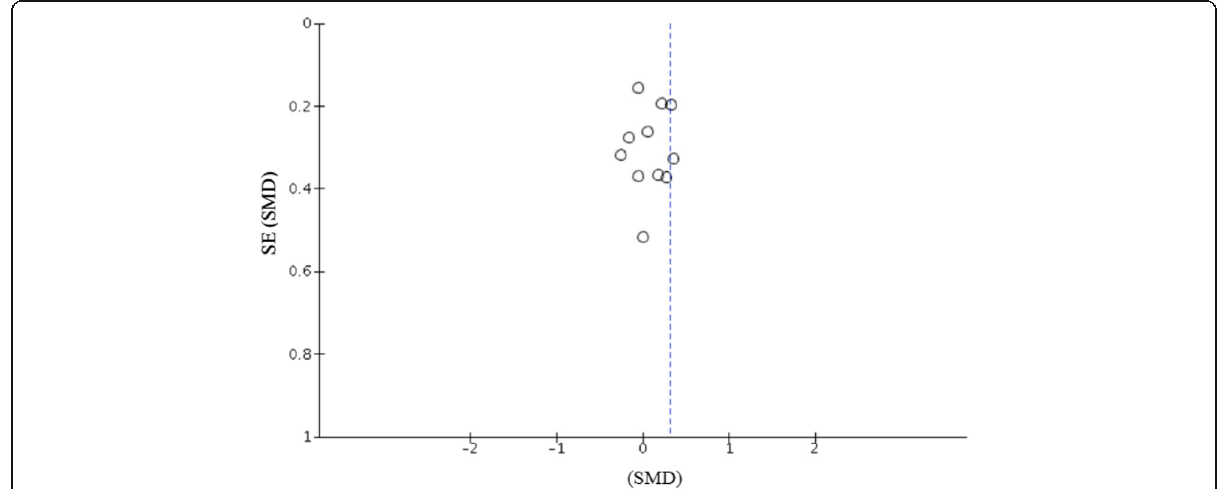
Fig. 5 Funnel plot of standard error (SE) by the standard mean difference (SMD) for assessment of publication bias with included resistance training frequency studies (Schoenfeld et al. [50] data excluded). Each open circle denotes a study included in the meta-analysis. The blue dashed vertical line represents the overall effect calculated with the random-effects